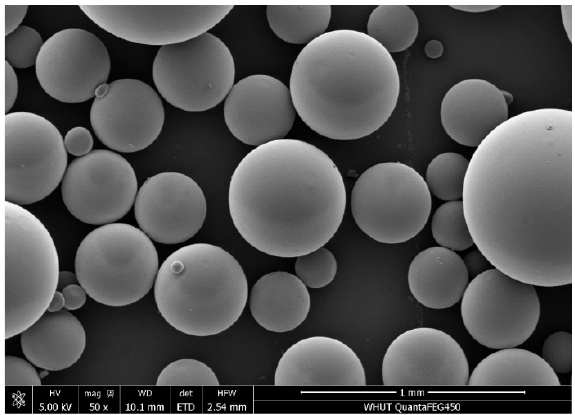
Figure 4. SEM and adsorption kinetics of spherical resin. The water absorption of SAP in deionized water, tap water, sodium chloride solution and w/c of 0.3 pore fluid were 180, 110, 20 and 12 times, respectively, according to Figure 5.